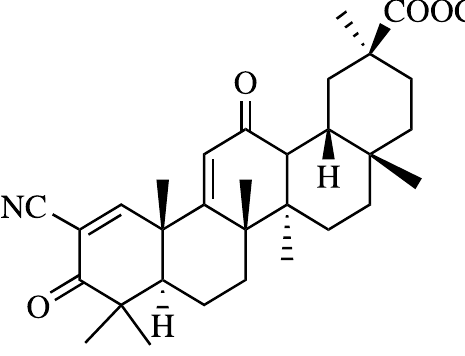
Figure 1. Chemical structure of methyl 2-cyano-3,12-dioxo-18 β H-olean-9(11),1(2)-dien-30-oate (Soloxolone methyl,